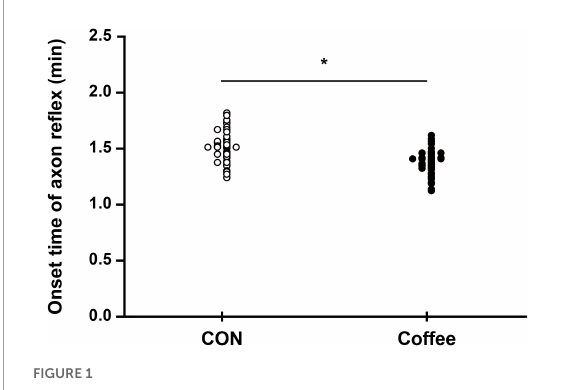
FIGURE1 Comparison of sweating activity between CON and Coffee groups showing the sweat onset-time of axon reflex (AXR) [threshold or latency of sweating AXR (1)]. Statistical significance difference, * p < 0.05. CON, no coffee group ( n = 40); Coffee, coffee intake group ( n = 40).